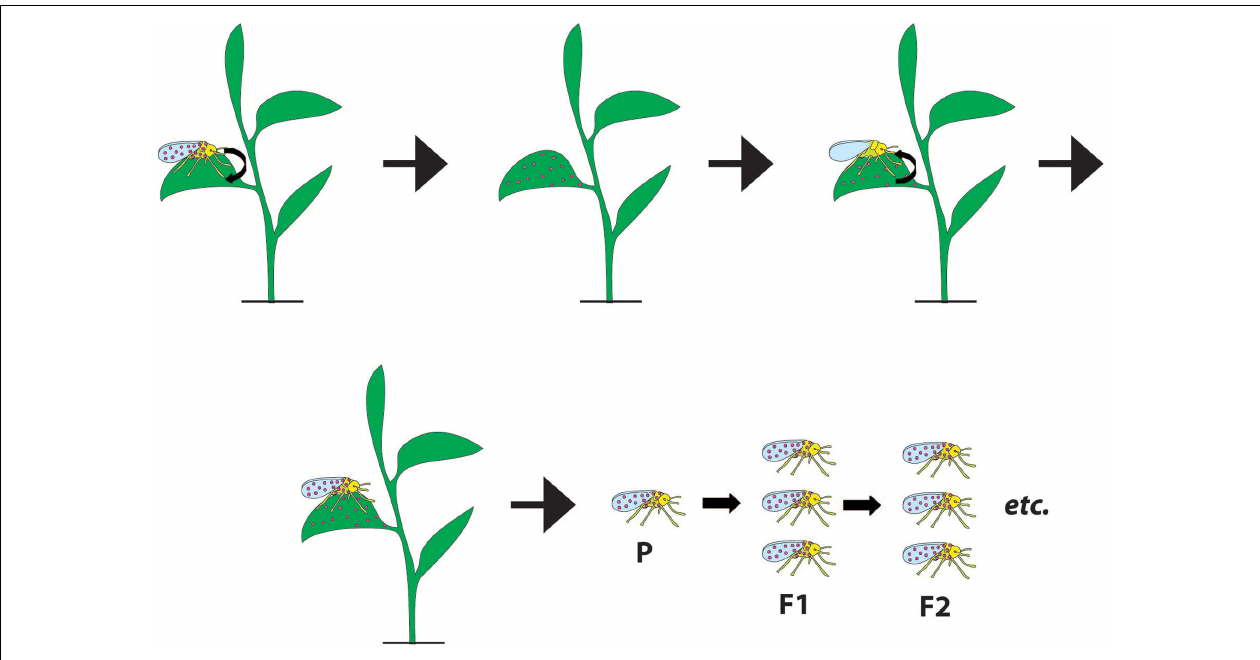
FIGURE 1 | Schematic overview of the plant-mediated symbiont transfer. The process requires insect-to-plant symbiont transfer, symbiont’s survival, and persistence in a plant (where the symbiont may or may not disseminate), plant-to-insect transfer and successful establishment in the new insect. A subsequent vertical transmission of an acquired symbiont can increase its prevalence, however, even the transient infections could impact host populations. Small black arrows indicate symbiont moving between organisms. P stands for the parent, F1 is the progeny of the parent, and F2 is the progeny of the